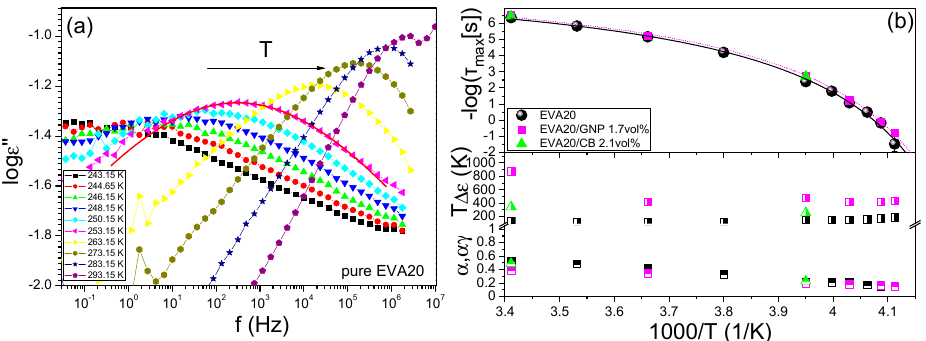
Figure 3. ( a ) Dielectric loss of EVA20 as a function of frequency at atmospheric pressure obtained on cooling. The solid line is an example of the fit to the HN function (2). ( b ) Top: Arrhenius relaxation plot of the segmental ( α -) process of EVA20 (black circles) and characteristic composites with GNP (violet squares) and CB (green triangles) close to the conductivity threshold. The data have been fitted with the VFT equation. Bottom: The temperature dependence of the HN shape parameters α = αγ (squares) and T Δε (circles) of the three samples.